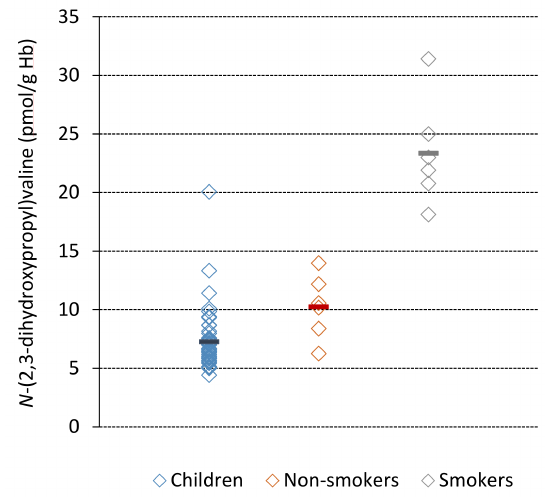
Figure 3. N -(2,3-Dihydroxypropyl)valine adduct levels in blood from children ( n = 50) and, non-smoking ( n = 6) and smoking ( n = 6) adults. The mean values are marked as horizontal bars. The higher level observed in the smokers is likely due to presence of glycidol in tobacco smoke (see Section 4). Table 1. (A) Measured steady state Hb adduct levels ( N -(2,3-dihydroxypropyl)valine) in blood samples from children and adults and corresponding calculated daily adduct level increments, and (B) the corresponding estimated daily in vivo doses (AUC) and intakes of glycidol. A B Daily Hb Adduct Group Daily Intake Daily AUC b Hb Adduct (pmol/g Hb) Level Increment ( µ g/kg/day) (nMh) (pmol/g Hb) Subjects ( n ) Mean a ±